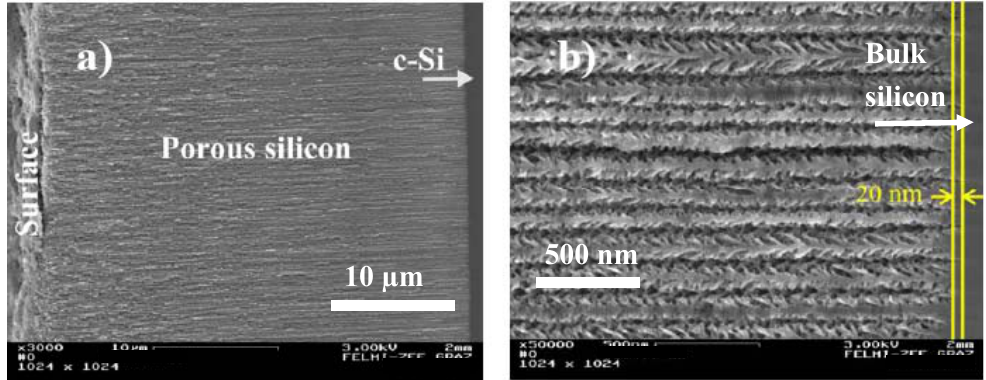
Figure 11. (a) SEM-image of the entire porous layer of 35 µm, (b) shows the pore-tip region in detail exhibiting a deviation of the pore-length of about 20